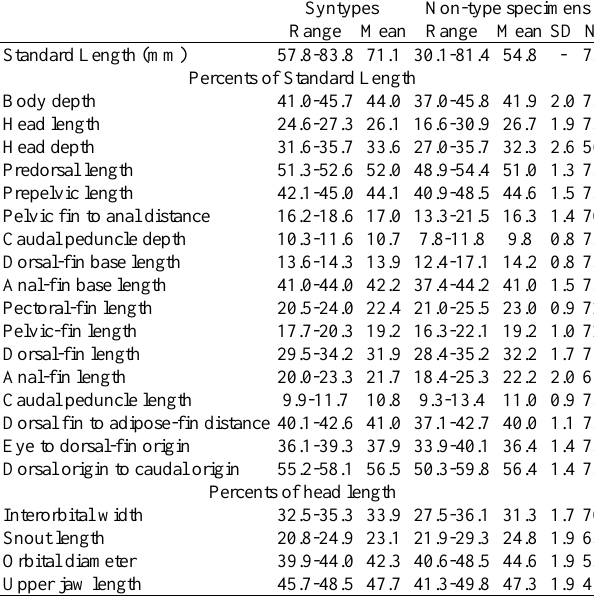
Table 2. Morphometric data for Moenkhausia doceana : syntypes (MNHN 1913-135, 1; MNHN 1913-136, 1; NMW 57389, 2; and NMW 57591, 2). N = number of non-type specimens, SD = Standard Deviation (not including syntype